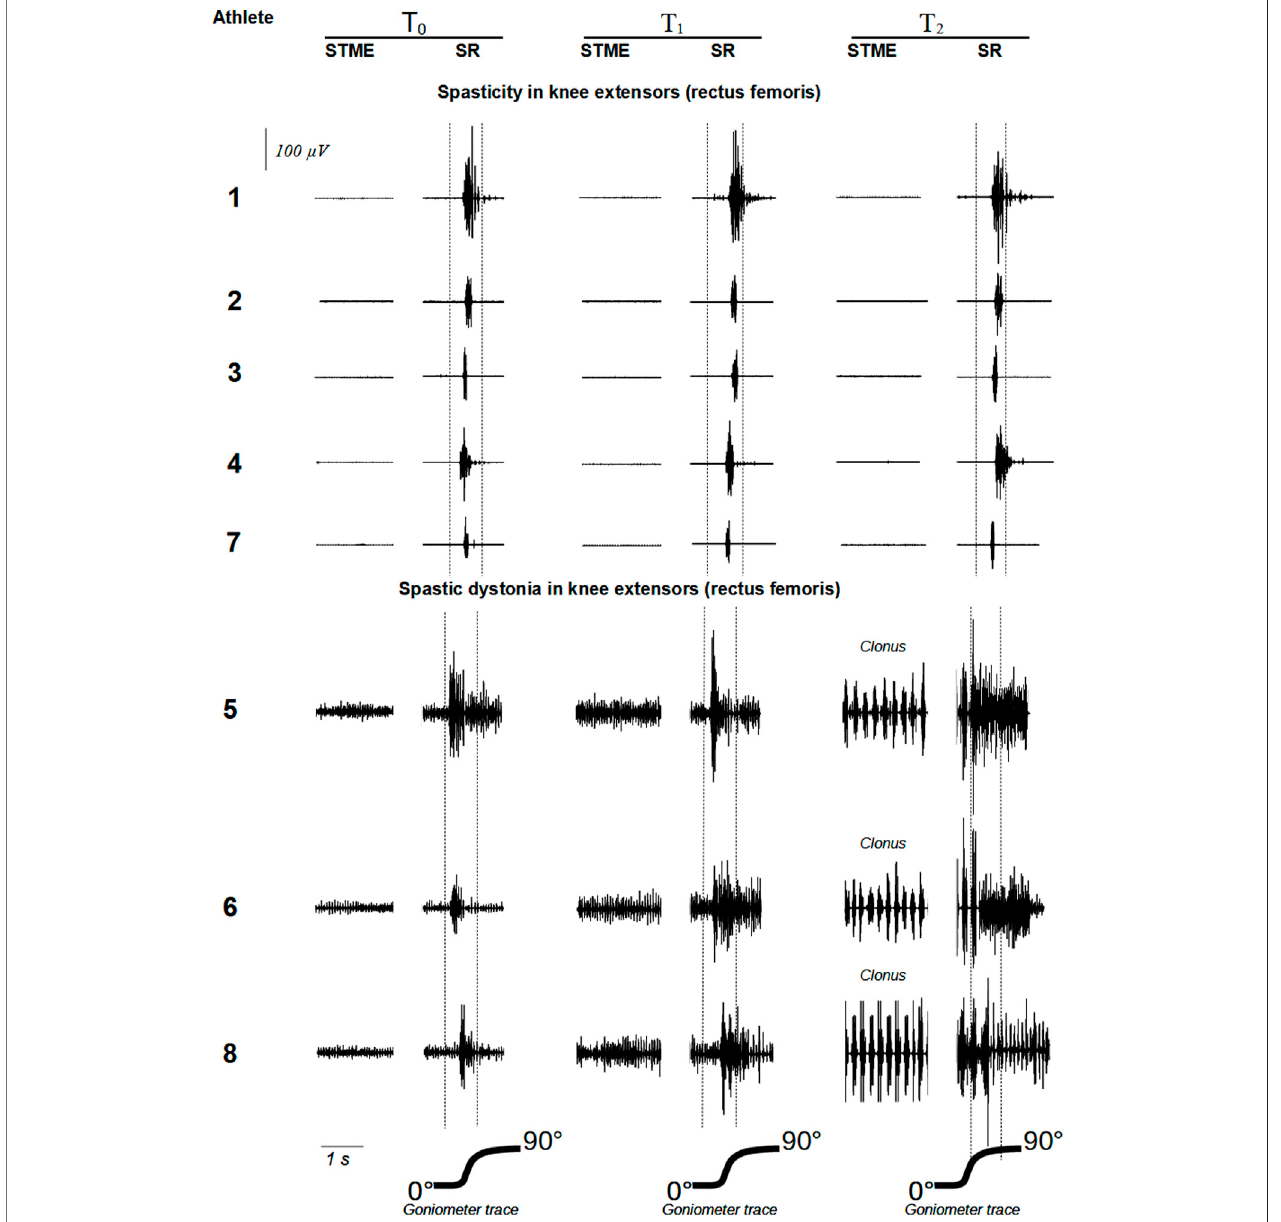
FIGURE 3 | show raw EMG signals from rectus femoris and biceps femoris , respectively. Abbreviations: STME (spontaneous tonic muscle excitation); SR (stretch re fl ex).